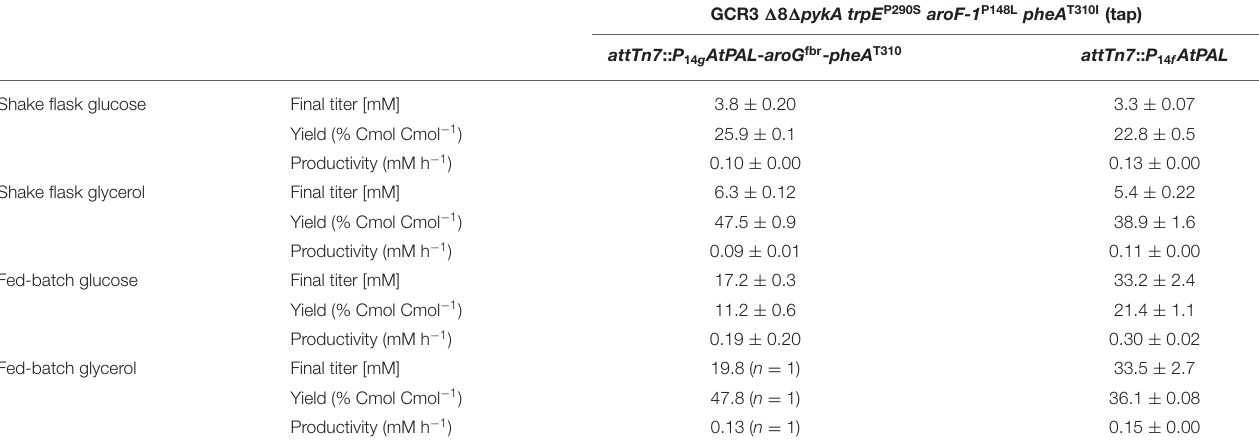
TABLE 3 | Comparison of t -cinnamate titer, yield, and volumetric productivity of strains P. taiwanensis GRC3 1 8 1 pykA -tap attTn7 ::P 14g AtPAL- aroG fbr -pheA T310 and GRC3 1 8 1 pykA -tap attTn7 :: P 14 f AtPAL in shake flask cultivations and fed-batch